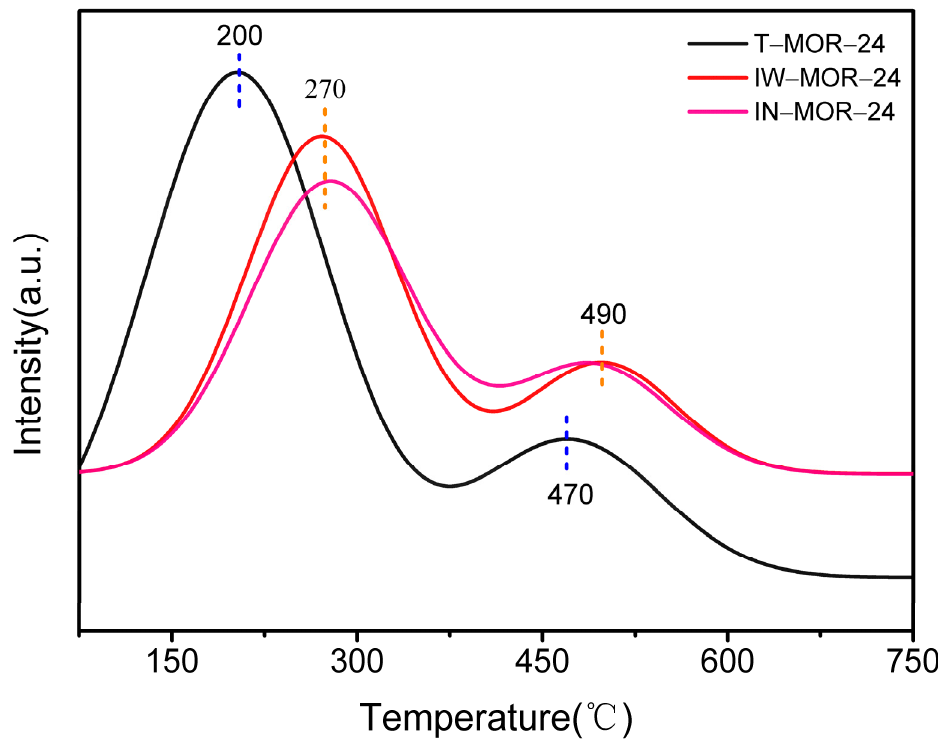
Figure 11. NH 3 –TPD profiles of T–MOR–24, IW–MOR–24 and IN–MOR–24 samples.